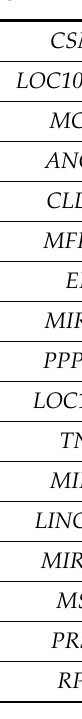
Table A1. Genes in frequently gained region of chromosome 8p in